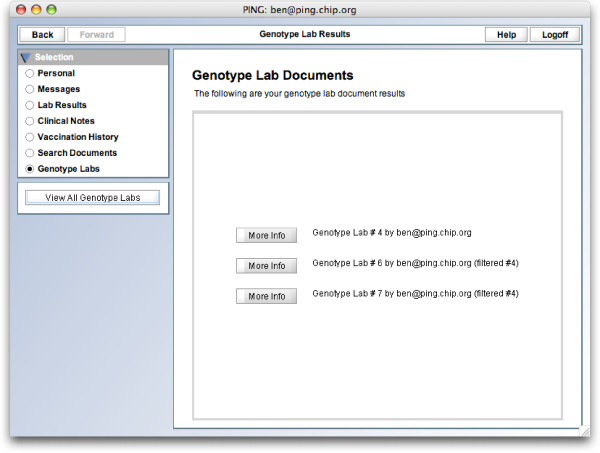
GenePING genotype lab list view. A patient's view of his list of genotype datasets.